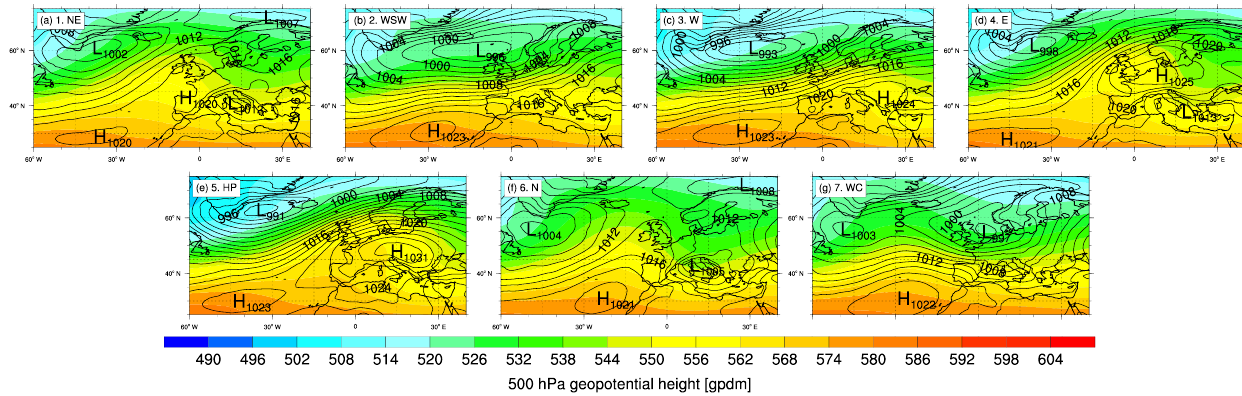
Figure 3. CAP7 1958–2009 500hPa geopotential height (colour) in gpdm and sea level pressure (contours) in hPa JFM composites.